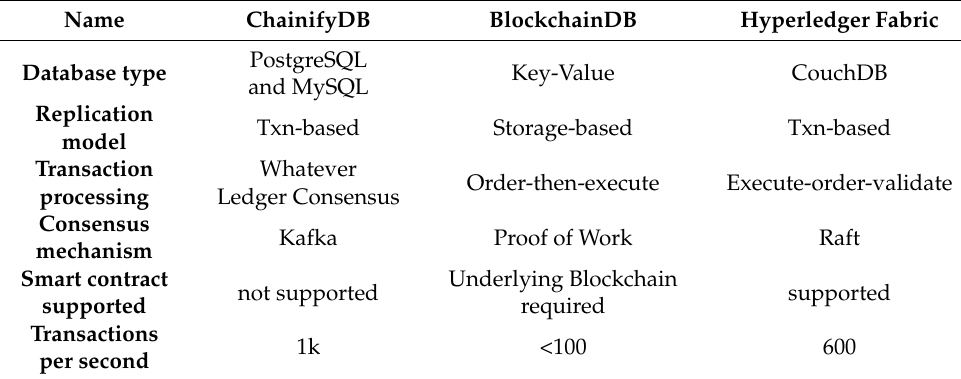
Table 3. Overview of discussed permissioned blockchain